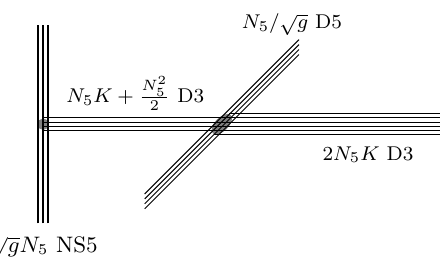
Figure 9. Brane configuration described by the supergravity solution (2.8) after the SL(2 , R ) transformation (4.2). The parameter g should be chosen such that the 5-brane numbers are integer. Along the first ellipsis the rank increases in steps of R/ √ steps of S/ g . The total number of 3d nodes is 3d/4d quiver